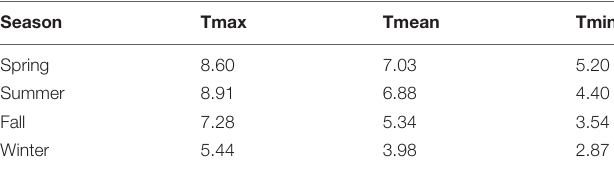
TABLE 2 | Seasonal near-surface lapse rates ( ◦